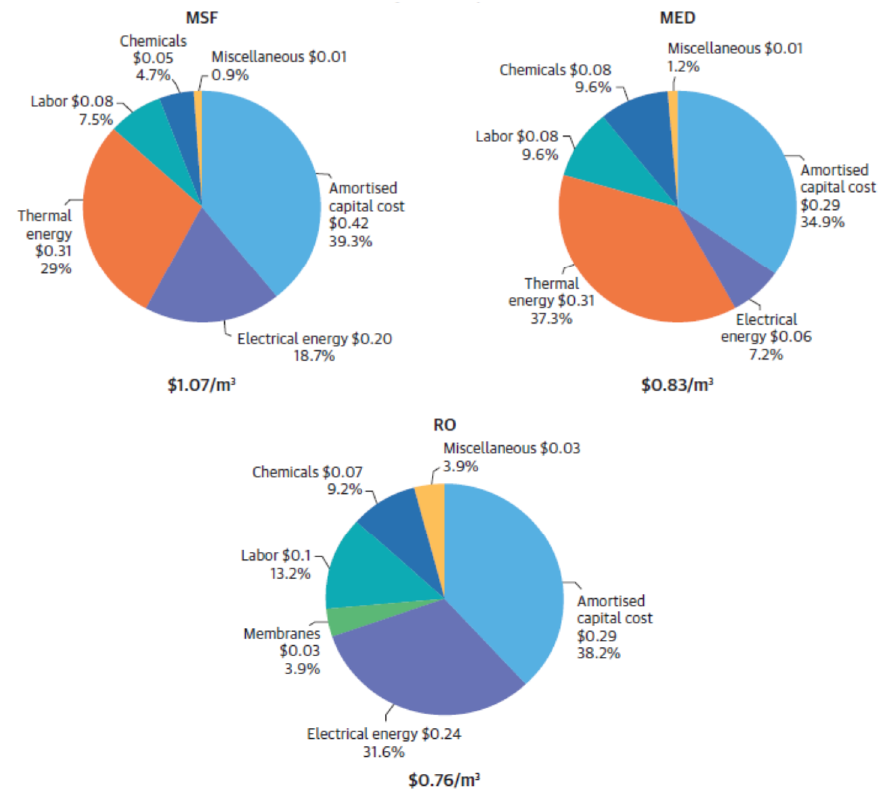
Figure 6. Cost component of the thermal desalination and reverse osmosis technologies [39]. ( © 2019 International Bank for Reconstruction and Development / The World Bank). Table 6. Pollutants emission levels for powering Mult-Stage Flash (MSF) and Reverse Osmosis (RO) plants [39].